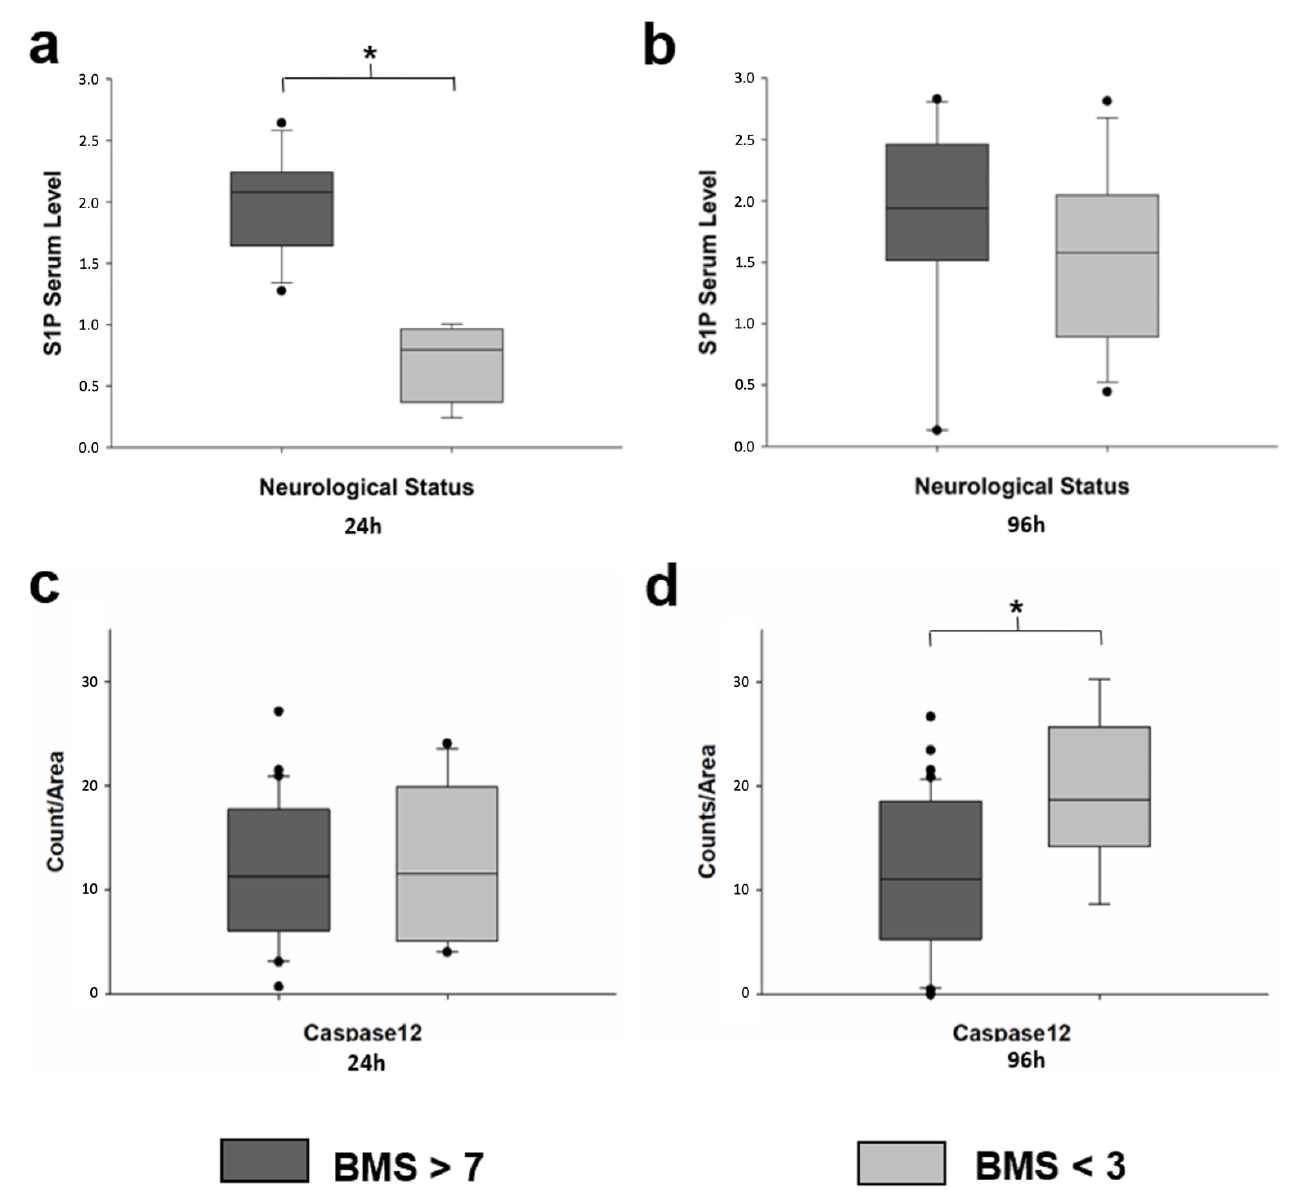
Figure 3. Serum level of S1P and immunohistochemistry for caspase-12 of animals with a BMS > 7 and < 3. Basso mouse scale (BMS) > 7 in dark grey and BMS < 3 in light grey. Boxes indicate the upper and lower quartile, the line indicates the median, the upper and lower whisker indicate 2.5%- and 97.5% quantile, and black circles indicate values that are outside 2.5%- and 97.5% quantile. ( a ): Serum levels of S1P of after 24 h RT. * BMS > 7 ( n = 11) vs. <3 ( n = 4) p < 0.001 ( t -test). ( b ): Serum levels of S1P after 96 h. ( c ): Results of the immunohistochemical (IHC) evaluation of caspase-12 after 24 h. ( d ): IHC of caspase-12 after 96 h. * BMS > 7 ( n = 18) vs. <3 ( n = 16) p = 0.009 ( t -test).